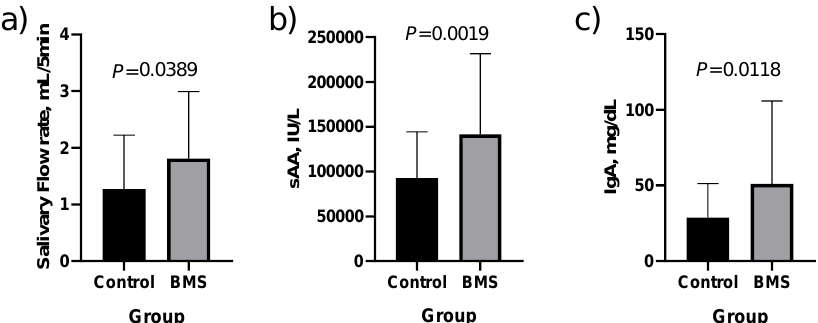
Figure 1. Salivary flow rate ( a ), salivary alpha-amylase (sAA; ( b )) and immunoglobulin A (IgA; ( c )) in healthy controls ( n = 31) and patients with burning mouth syndrome (BMS; n = 51). Di ff erences of medians and means ± SD for salivary flow are 0.54 and 0.75 ± 0.41, for sAA they are 48,660 and 109,536 ± 41,492 and for IgA they are 22.47 and 34.01 ±